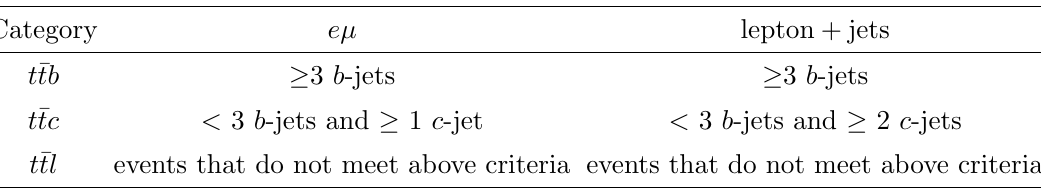
Table 4. Event categorisation (for the de(cid:12)nition of the MC templates) based on the particle-level selections of b -jets, c -jets and light-(cid:13)avour